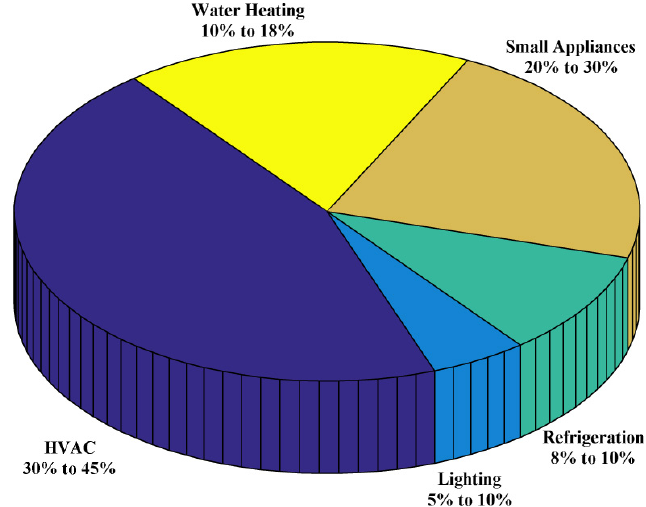
Figure 1. The average power consumption of